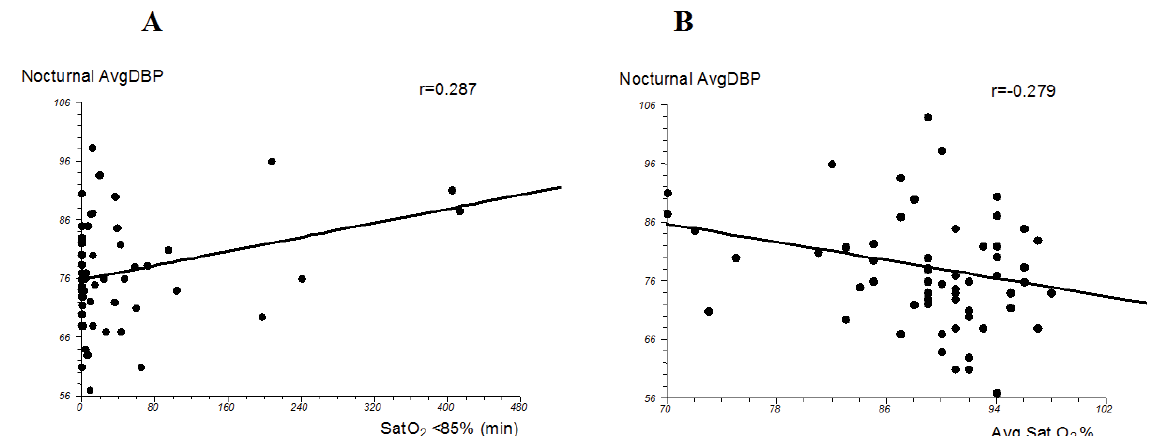
Figure 2. Correlation of nocturnal average diastolic blood pressure (AvgDBP) with duration of oxygen saturation (SatO with average SatO